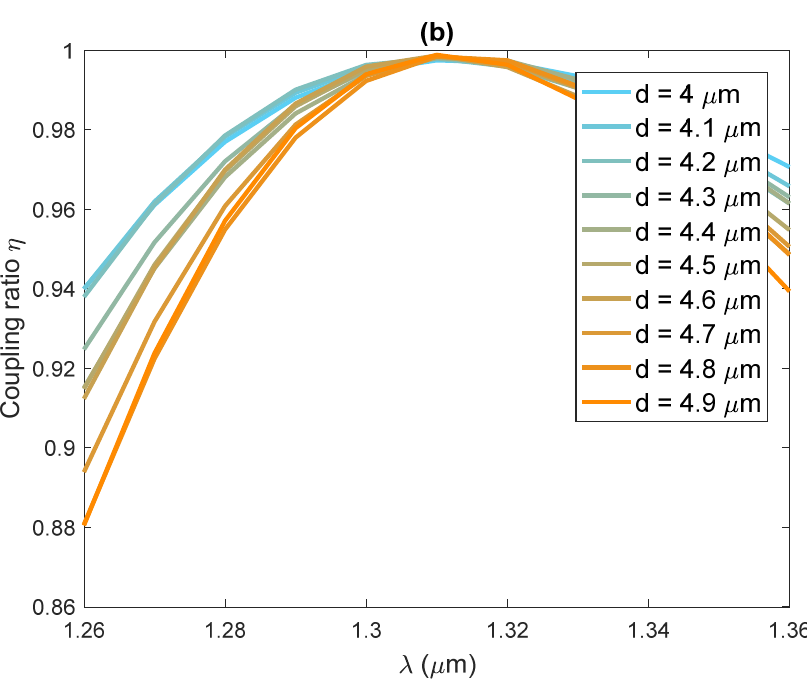
Figure 4. ( a ): Coupling length as a function of wavelength and core-to-core separation d ; ( b ) coupling ratio η as a function of wavelength and core-to-core separation d .